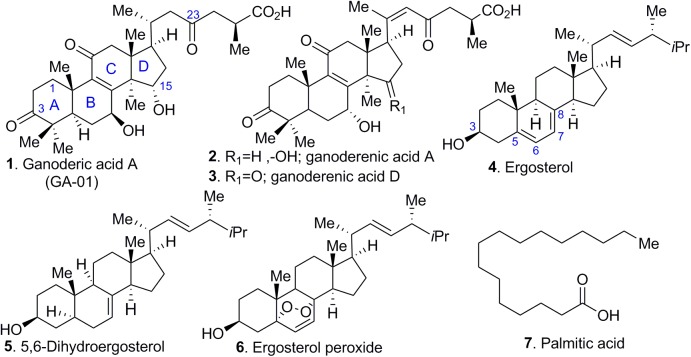
Selected chemical constituents of GLE. Compounds extracted from Ganoderma lucidum include (1) ganoderic acid A, (2, 3) ganoderenic acid A and D, (4) ergosterol, (5) 5, 6-dihydroergosterol, (6) ergosterol peroxide, and (7) palmitic acid.